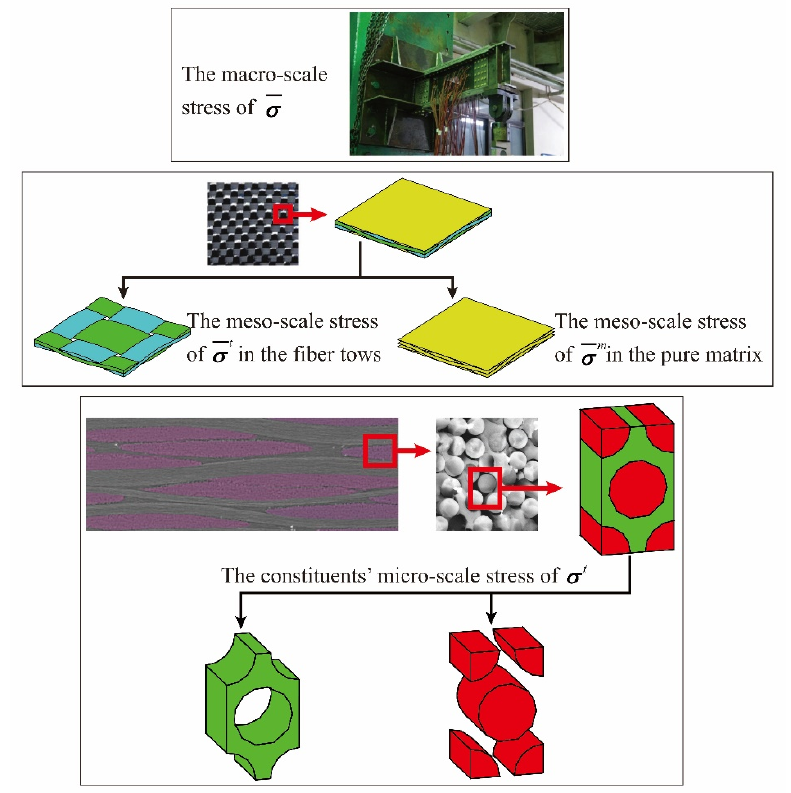
Figure 19. The classification of the stresses in the PWF composites according to the different analyzing